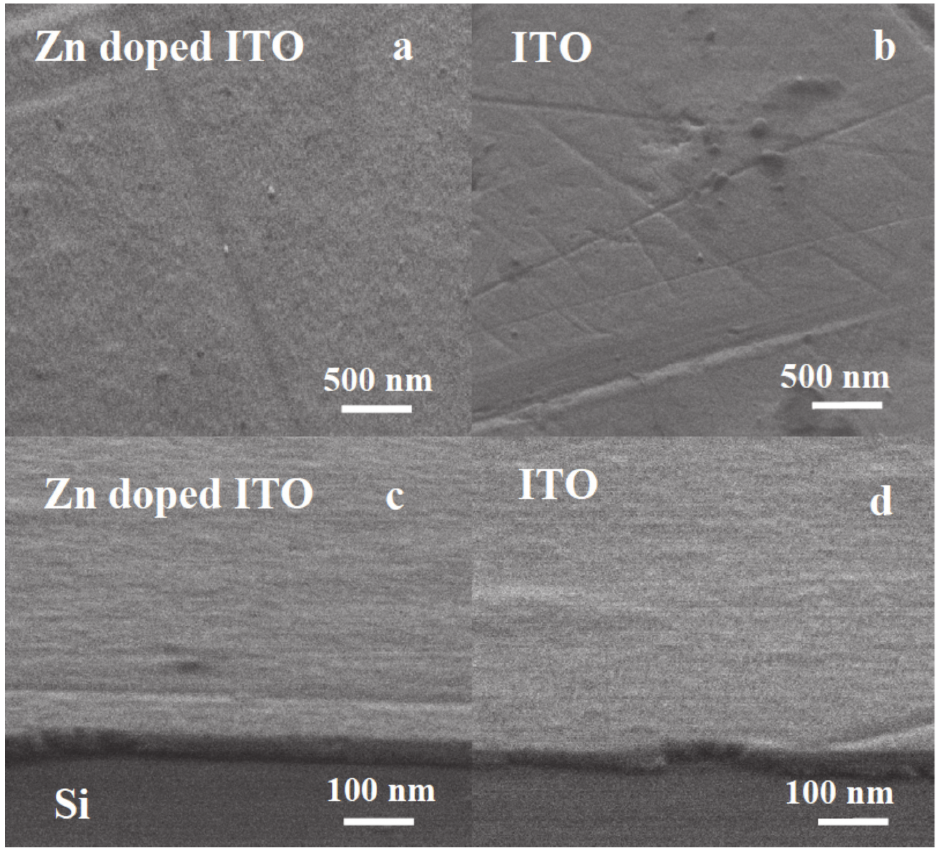
Figure 2. SEM micrographs at different magnification: ( a , b ) 100,000×, surface top view; ( c , d ) 500,000×, edge view. ( a – c ) ITO:Zn and ( b – d ) undoped ITO films. The darker gray area below the film edge in ( c , d ) is the underlying Si substrate.